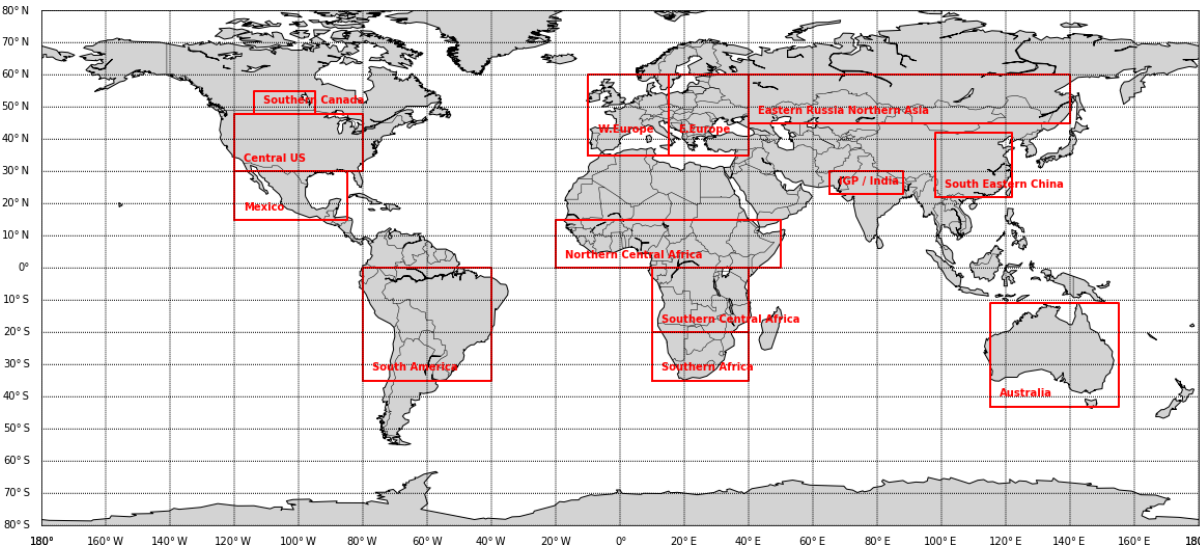
Figure 9. Delimitation of large regions of interest in which CrIS NH 3 are grouped together for regional time series analysis.